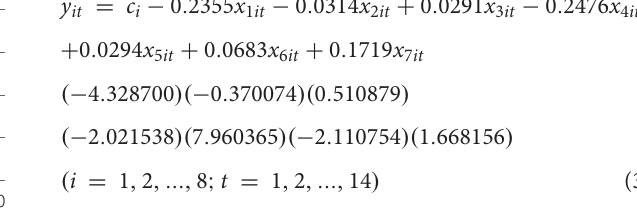
TABLE 6 | Hausman test results.